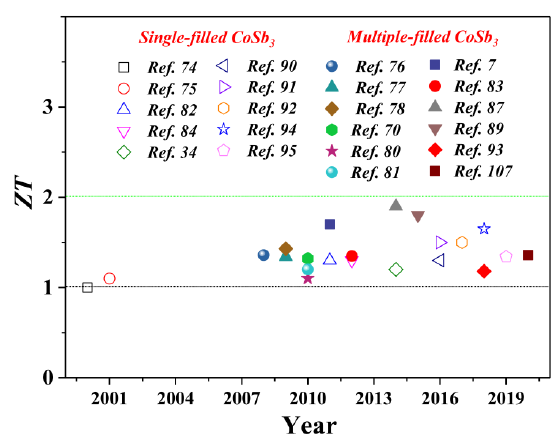
Fig. 5 Timeline of ZT for several typical CoSb 3 -based filled skutterudites TE materials.